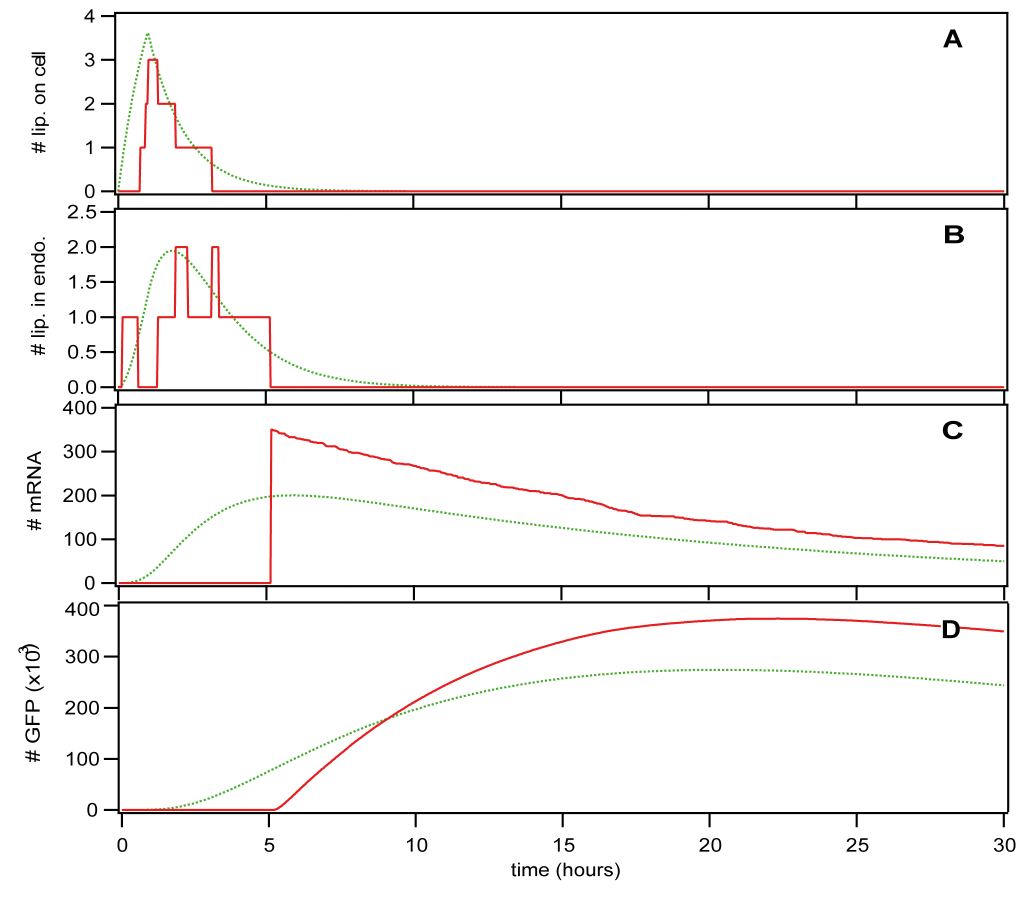
Figure 3. Simulation Time Courses. Green dotted (red full) line: deterministic (stochastic) simulation. A) Number of lipoplexes attached to the cell surface. B) Number of lipoplexes contained in endosomes. C) Number of mRNA molecules in the cell. D) Number of GFP molecules in the cell.